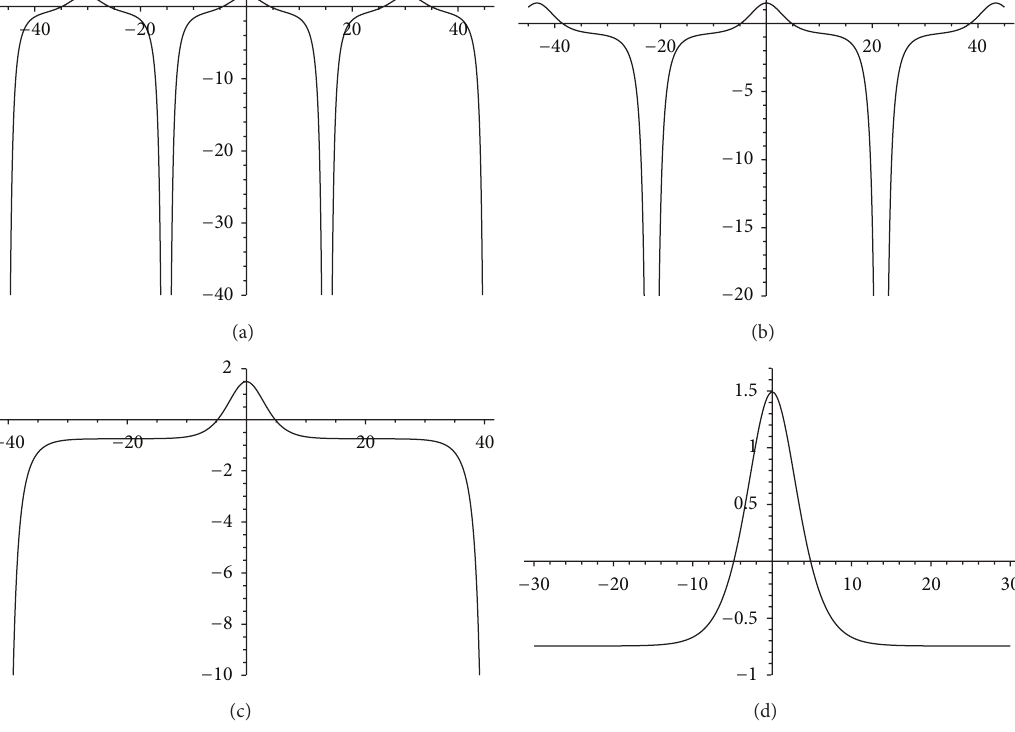
Figure 6: The varying process for graphs of 𝑢 14 (𝜉) when 𝑐 > 𝛼 and 𝑔 → 𝑔 0 + 0 where 𝛼 = 𝛽 = 𝛾 = 1 , 𝑐 = 2 , and (a) 𝑔 = 𝑔 0 + 1/5 . (b) + 10 −2 . (c) 𝑔 = 𝑔 + 10 −6 . (d) 𝑔 = 𝑔 + 10 −8 𝑔 = 𝑔 0 0 0